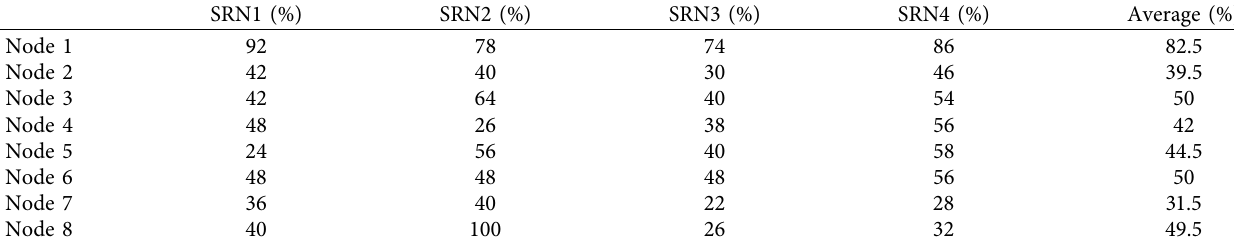
Table 2: HRDE recognition rates for four types of SRN.